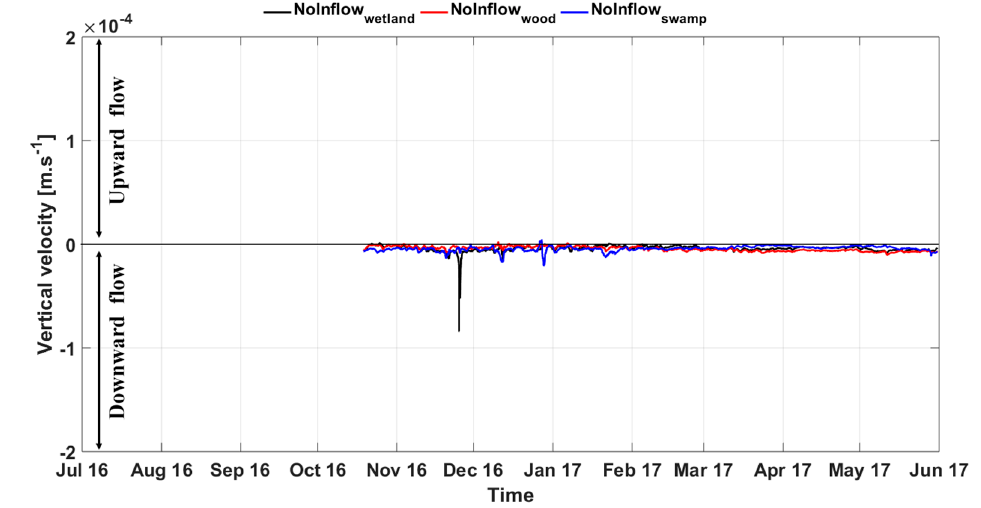
Figure 6. Vertical flow velocities along the hyporheic zone from locations without groundwater inflows (Neutral) estimated by VFLUX2 from z2 = − 10 cm to z1 = 0 cm (i.e., negative values indicate downward flows).